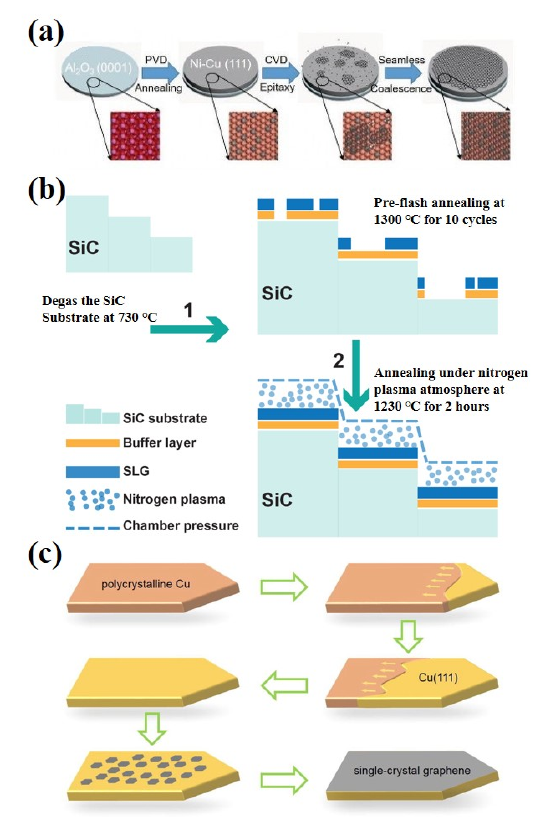
Figure 3. ( a ) Schematics for the fabrication of wafer-scale single-crystal graphene on Cu/Ni (111) alloy film at low temperature. Reprinted with permission from Ref. [62]. Copyright 2019, Wiley Online Library. ( b ) Schematic diagram of preparing uniform SLG on 4H-SiC (0001). The figure involves three main processes: the degassing of the substrate, pre-flash annealing, and annealing under a nitrogen plasma atmosphere. Reprinted with permission from Ref. [63]. Copyright 2021, MDPI. ( c ) Schematic diagram of ultrafast epitaxial growth of large-size graphene films. Reprinted with permission from Ref. [64]. Copyright 2017,